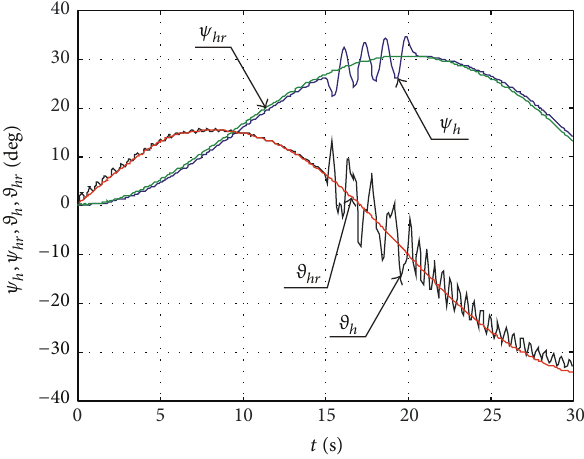
and 𝑀 for in ex